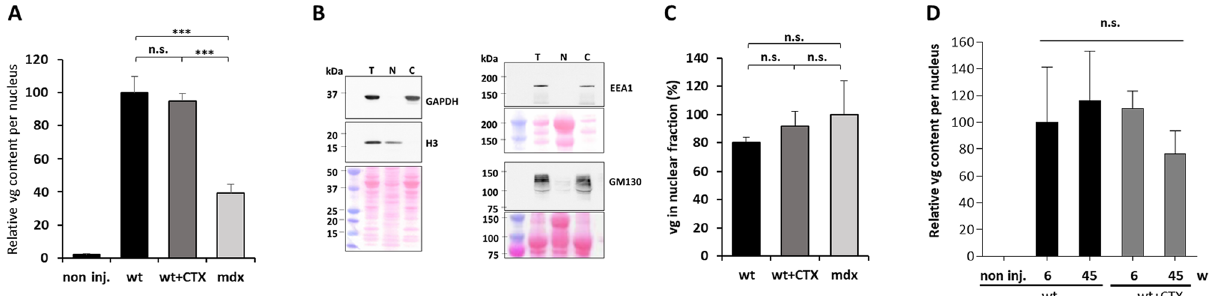
Figure 3. Impact of muscle regeneration on vector genome content and its intracellular localization. ( A ) Quantification of AAV genomes per nucleus by absolute qPCR in wt, wt + CTX and mdx muscles injected with AAV1-mSeAP vector. Three weeks after AAV injections, TAs were collected and analysed . Considering the higher numbers of total nuclei in wt + CTX and mdx muscles compared to wt muscles, the obtained data for these muscles were adjusted by a correcting factor (1.7 and 1.5, respectively). AAV genome content is expressed as the AAV genome number relative to the value obtained for wt muscles. Non inj., wt non-AAV injected TA. ( B ) Western blot analysis of total (T), nuclear (N) and cytosolic ( C ) fractions from the three muscle groups using GAPDH and H3 antibodies, confirming cytosolic and nuclear enrichments. EEA1 and GM130 antibodies detect markers of early endosomes and Golgi apparatus present in the cytosolic fractions validating the nuclear fraction purity. ( D ) AAV genomes were quantified by absolute qPCR in nuclear and total fractions from the three muscle groups and the proportion of vg present in nuclear fractions was calculated. ( D ) Quantification of AAV genomes per nucleus by absolute qPCR 10 month after regeneration. Considering the higher numbers of total nuclei in wt + CTX muscles compared to wt muscles, the obtained data for wt + CTX were adjusted by the correcting factor 1.7. AAV genome content is expressed as the AAV genome number relative to the value obtained for wt muscles (6w). Non inj., wt non-AAV injected TA. The data represent the mean values of five TAs per group ± SEM. n.s., non-significant, *** P ≤ 0.001.